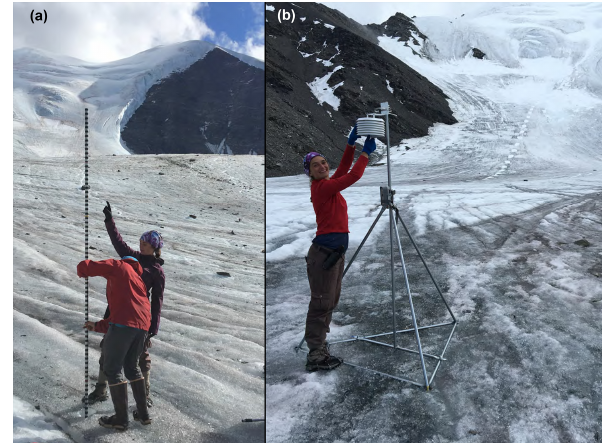
Figure 5. Examples of (a) ablation stakes (lower site) and (b) weather stations (upper site) installed on Chamberlin